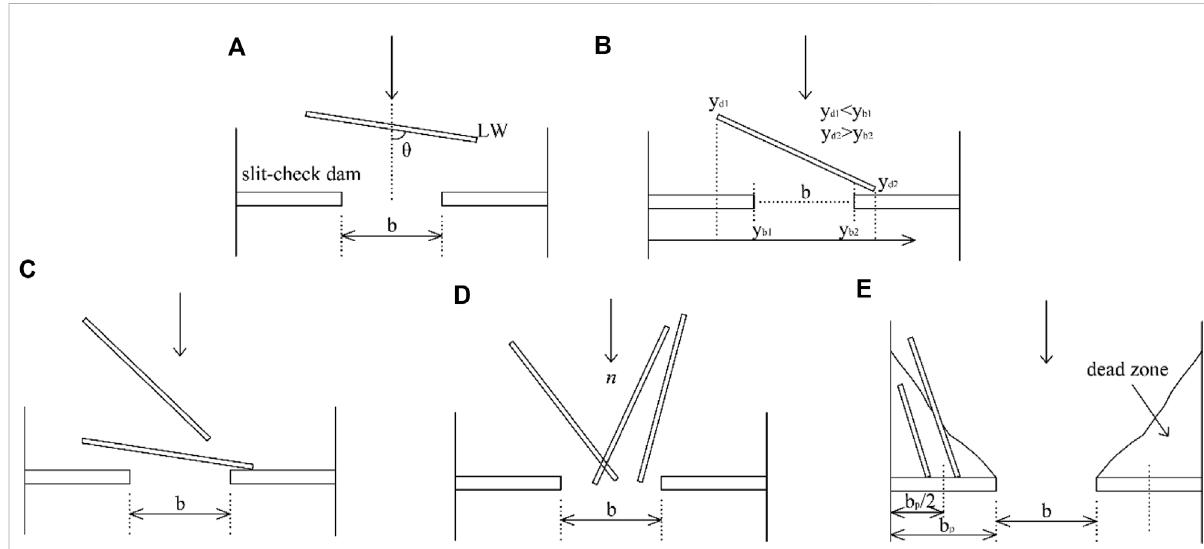
FIGURE 15 LWjammingattheslit-checkdam. (A) Apieceofdriftwoodwasjammedwithalargeorientationrangingfrom80 ° to90 ° . (B) Apieceofdriftwood was jammed in a slit-check dam due to geometric conditions as yd1 < yb1 and yd2 < yb2. (C) A piece of driftwood coming from the rear was also jammed by the pieces of driftwood already jammed in a slit-check dam. (D) The pieces of driftwood were jammed when the number of pieces of driftwoodarrivedattheslitopeningatthesametime. (E) Apieceofdriftwoodwasjammedinanimpermeablewidthoftheslit-checkdamwhen the centroid of the driftwood was located only inside the dead zone of fl ow (redrawn from Shrestha et al.